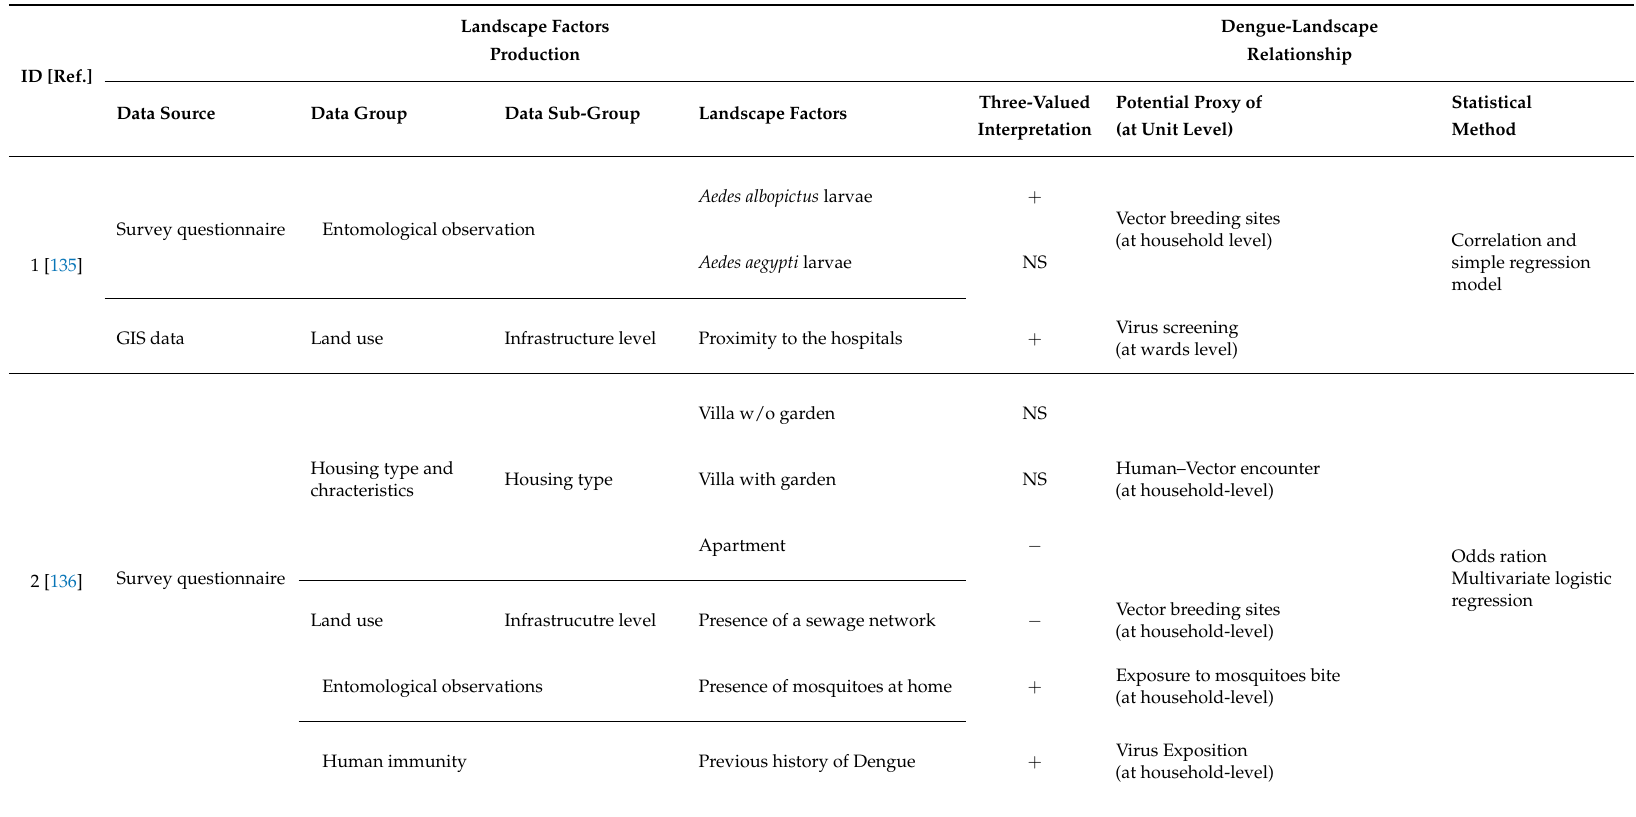
Table A3. Data extracted from the 78 articles on the landscape factor production (type of source), on the landscape factor classification according to groups and subgroups, and on the dengue-landscape relationship (three-valued interpretation: + , − , or NS, and statistical method performed).